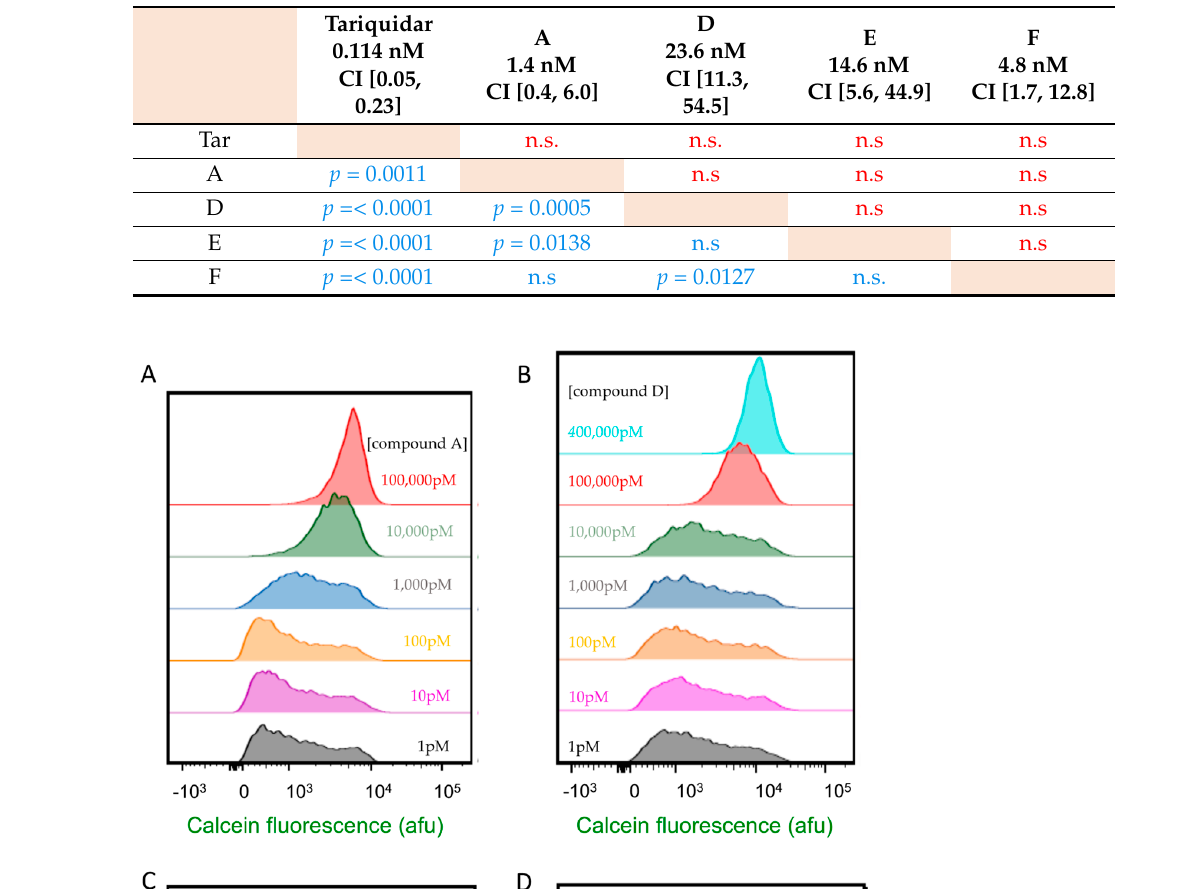
Table 3. Statistical significance of pairwise comparisons of potency (IC 50 in blue) and efficacy (bottom of the curve in red) by extra sum-of-squares F test of the fitted curves.